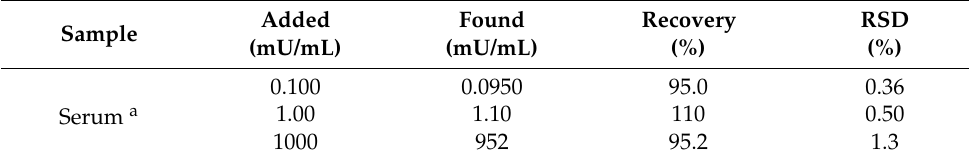
Table 2. Determination of CA19-9 in real samples a